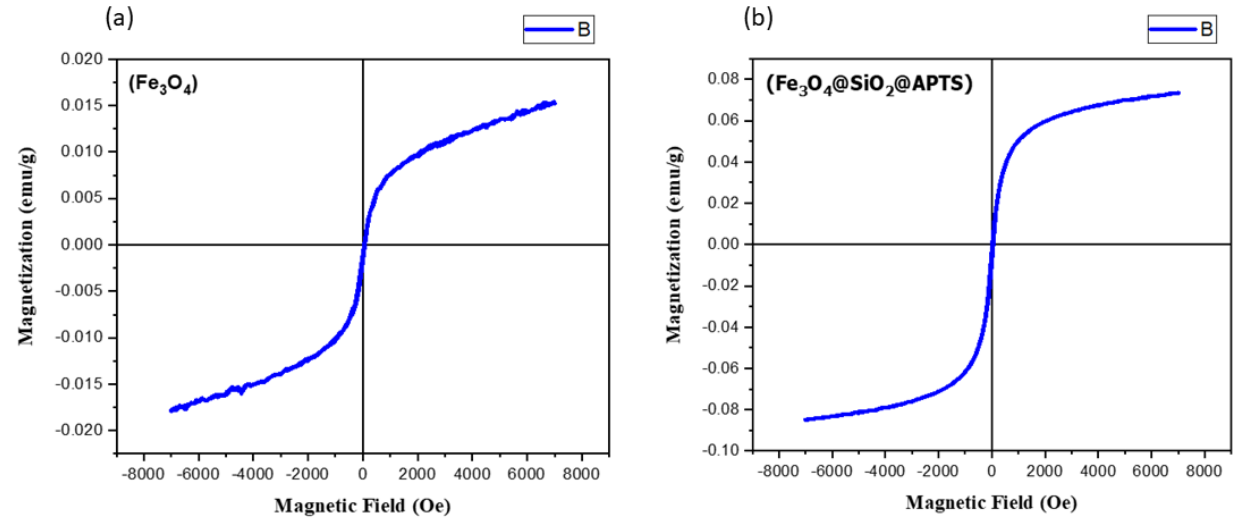
Figure 7. VSM magnetization curves for ( a ) Fe 3 O 4 and ( b ) Fe 3 O 4 @SiO 2